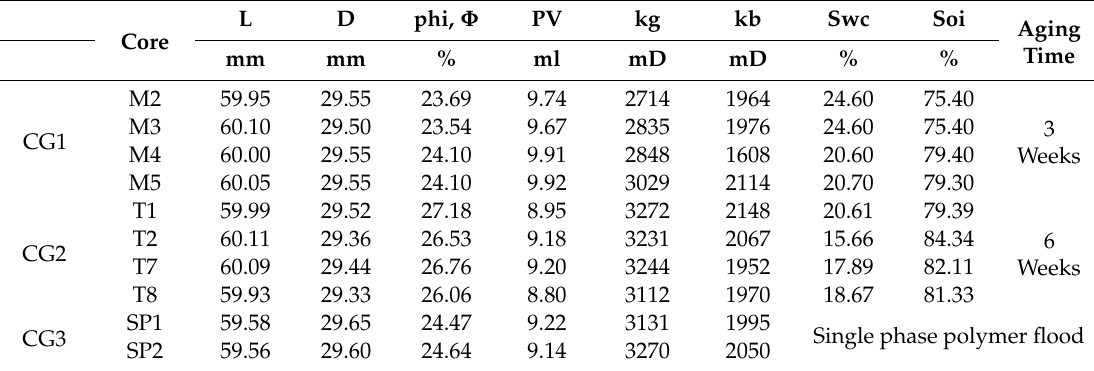
Table 3. Bentheimer core plug